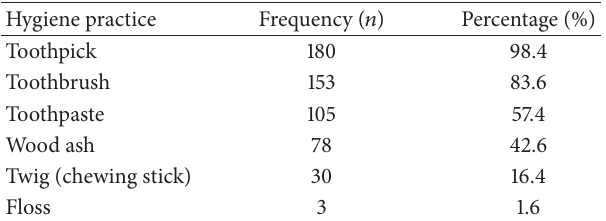
Figure 3: Distribution of the study population according to the toothbrushing frequency. Table 2: Distribution of the study population according to the oral hygiene practices.